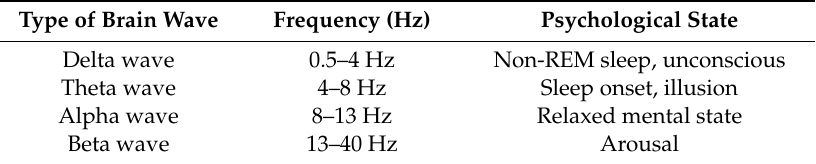
Table 1. Type of brain wave and psychological